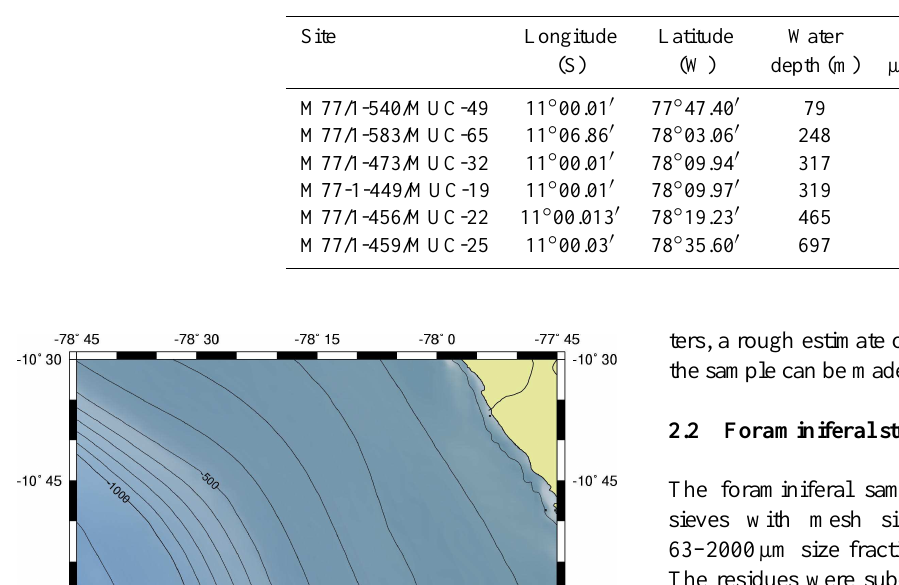
Table 1. Sampling sites for foraminiferal studies. Bottom water oxygen concentrations [O 2 ] BW in italics are taken from Glock et al. (2011). All other [O 2 ] BW are derived from close by stations of the conductivity, temperature, depth (CTD) sensor. Note that the detection limit for the CTD oxygen sensor was ∼ 2µmolkg − 1 .